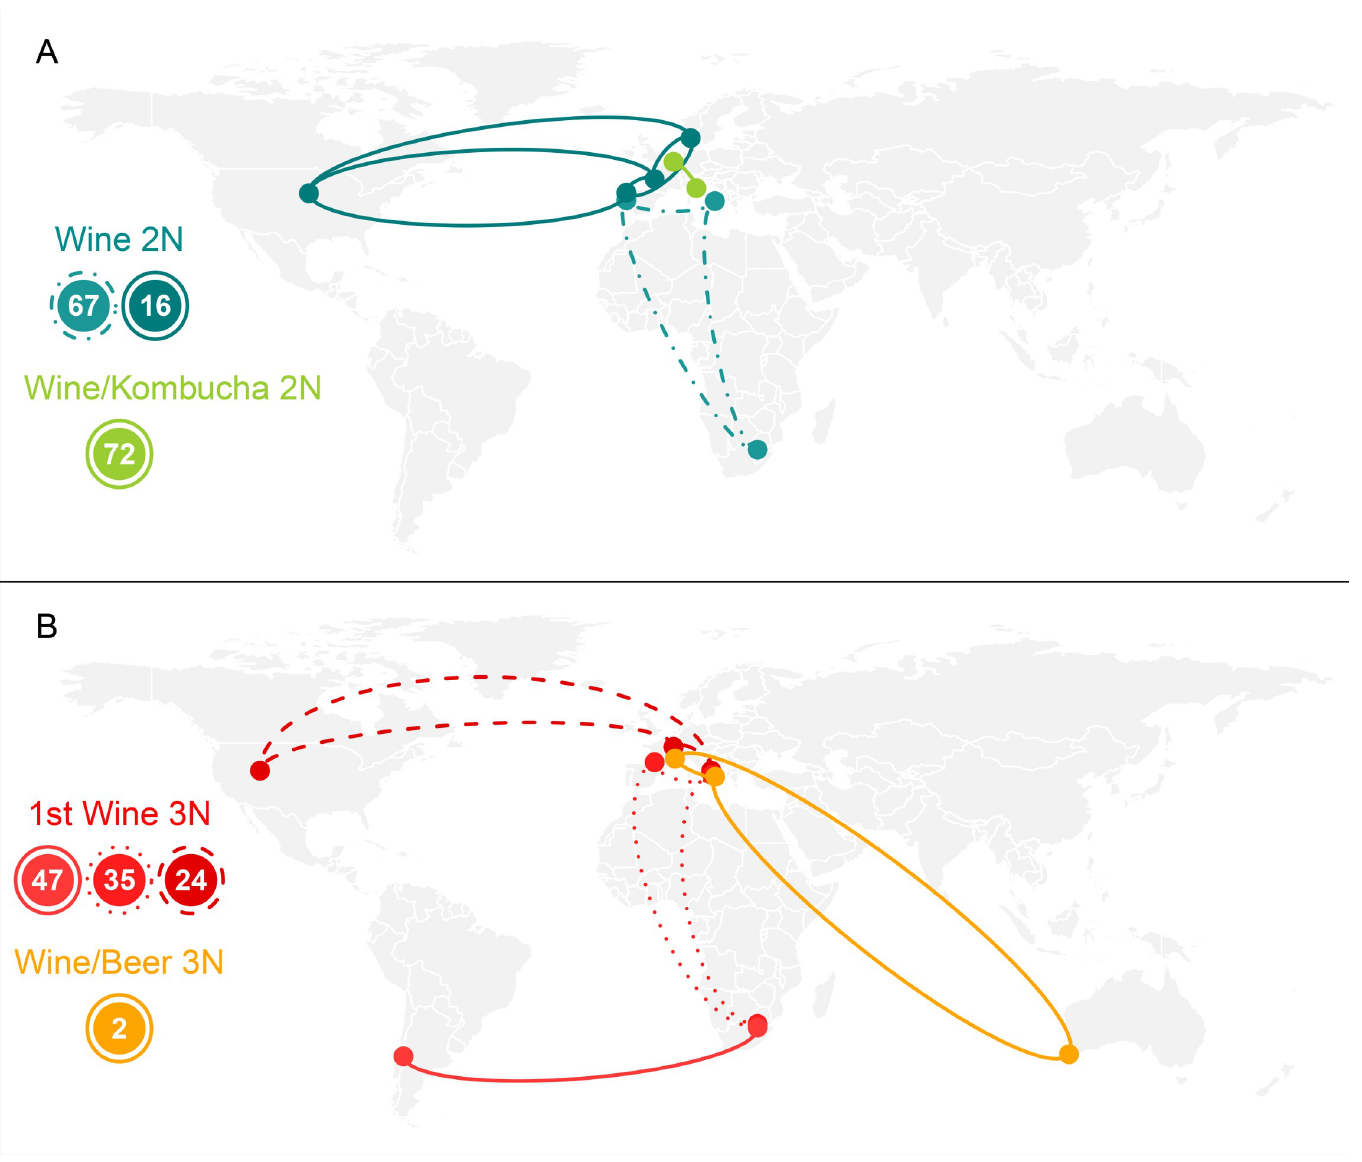
Fig 5. Examples of spatial dispersion of wine clones of B . bruxellensis . Over the 138 clone groups identified, 24 encompassed isolates from different countries. For clarity, only 7 of these groups (number 2, 16, 24, 35, 47, 67, 72) are represented here.